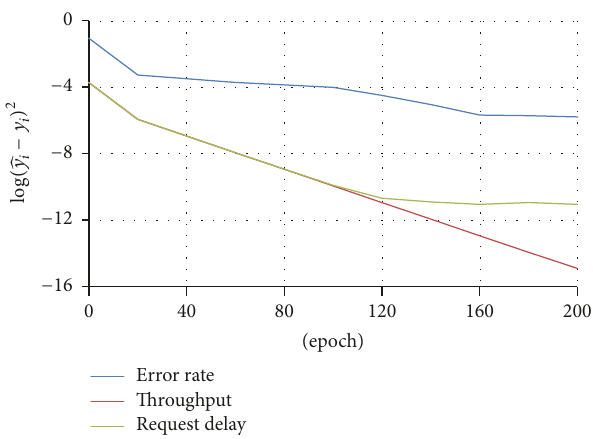
Figure 7: Illustration of declining trend of the error in training. Table 6: Proportion of each ID on data set